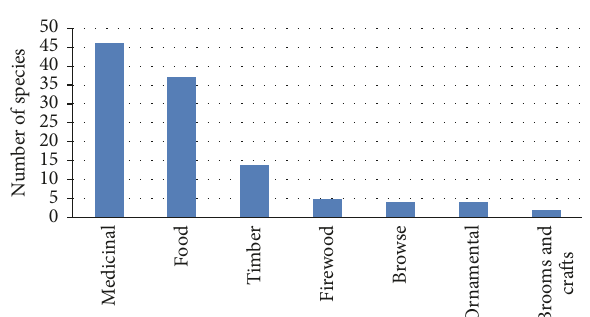
Figure 3: Plant use categories recorded in Ntabelanga catchment